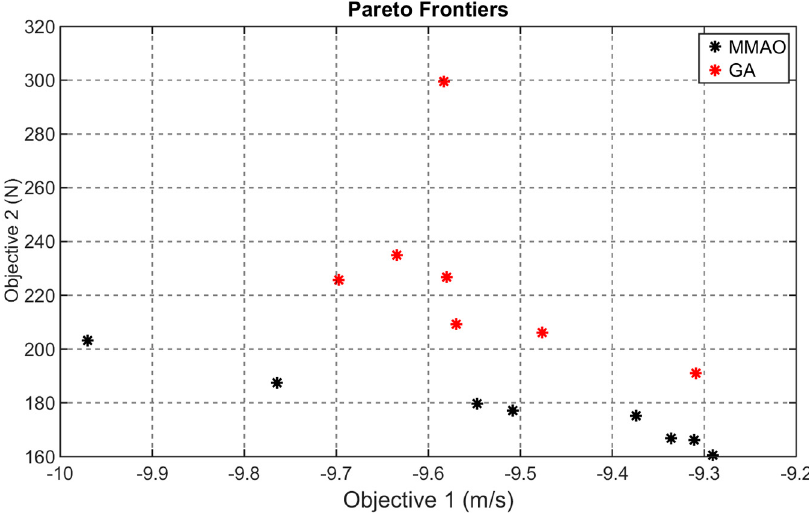
Figure 13. Pareto front plot for MMAO (OASIS) optimization and GA multi-objective optimization.